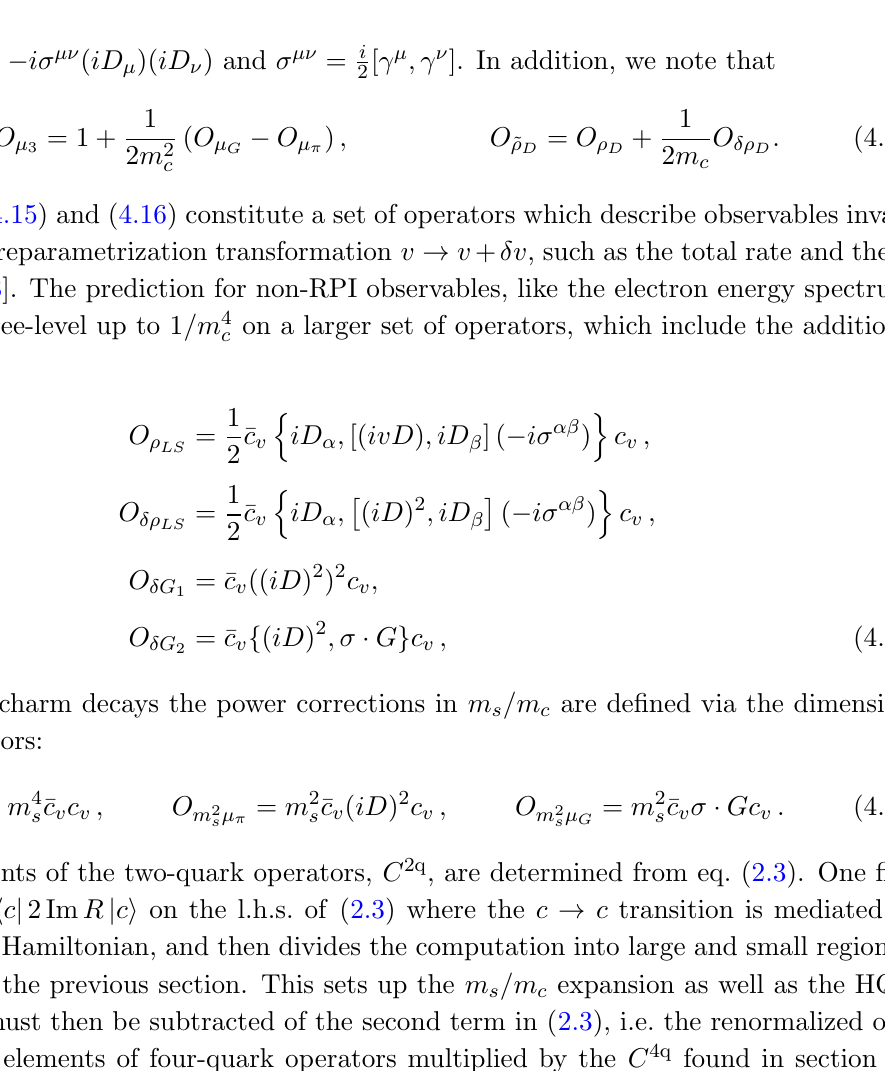
Figure 3 . Computation of the Wilson coe(cid:14)cients of two-quark operators. Matrix elements with either zero, one and two gluon must be